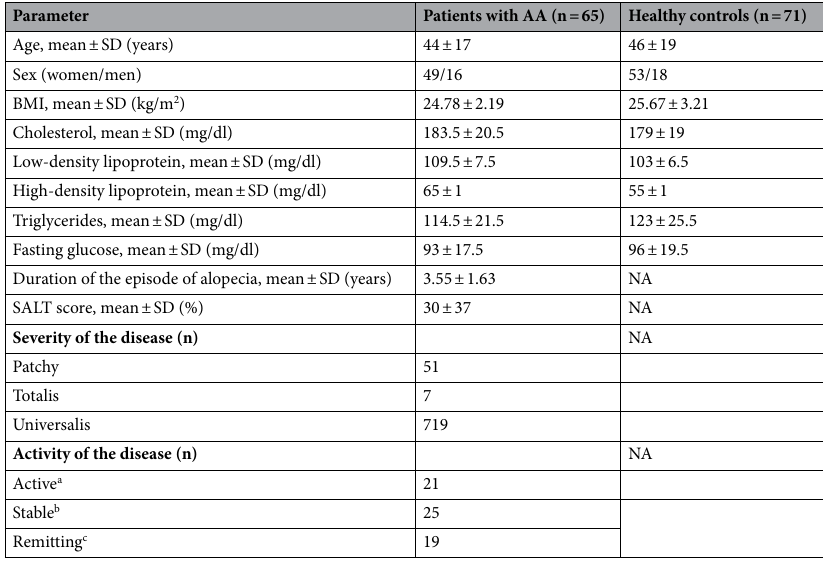
Table 1. Characteristic of patients with alopecia areata and healthy controls. BMI body mass index, SALT severity of alopecia tool, SD standard deviation, AA alopecia areata, NA not applicable. a Active alopecia